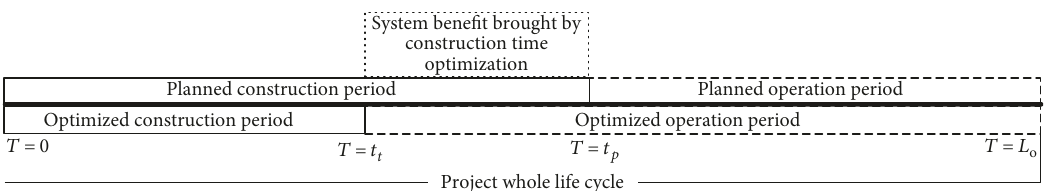
Figure 1: The impact of construction time compression on the system